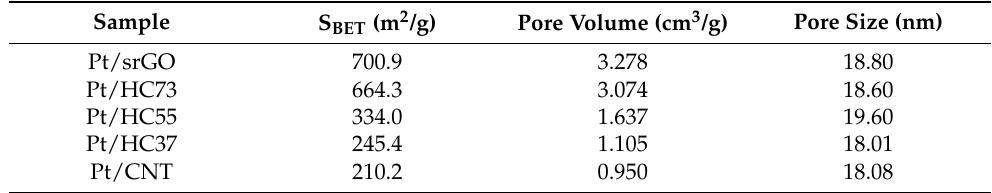
Figure 2. TEM images of ( a ) Pt/CB, ( b ) Pt/srGO, ( c ) Pt/CNTs, and ( d ) Pt/HC55. Table 1. Brunauer–Emmet–Teller (BET) analysis results for Pt/srGO, Pt/CNTs, Pt/HC73, Pt/HC55, and Pt/HC37.